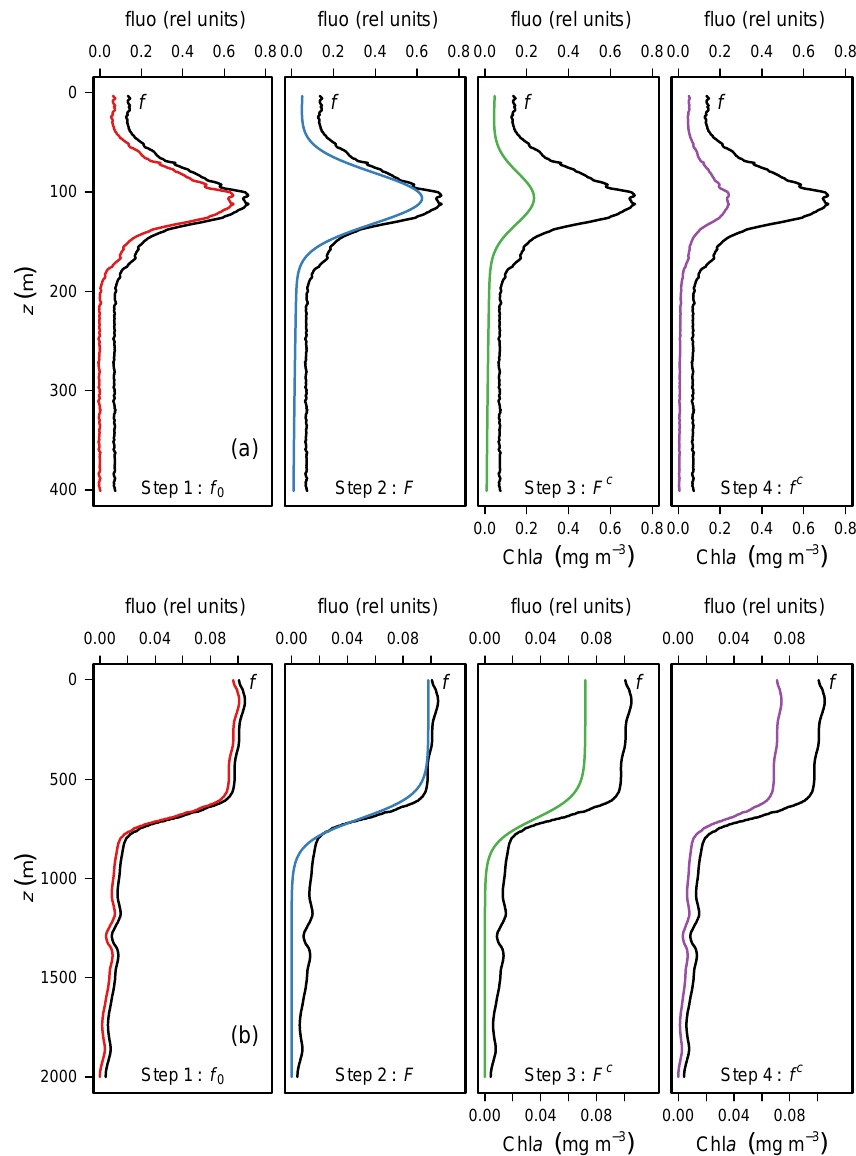
Fig. 10. The four steps of the calibration method for (a) gaussian profiles, (b) sigmoid profiles. Step1: the raw fluorescence profile f (z) (black curve) is set to 0 at the bottom, the resulting profile is f 0 (z) (red curve). Step 2: f 0 (z) is fitted by the appropriate parameterization (Eqs. 2 and 3), which give F(z) (blue curve). Note that for both steps, the profiles are in relative units. Step 3: F(z) is calibrated in Chl- a units (mgm − 3 ) , F c (z) (green curve). Step 4: f c (z) is the Chl- a -calibrated fluorescence profile (mgm − 3 ) (purple